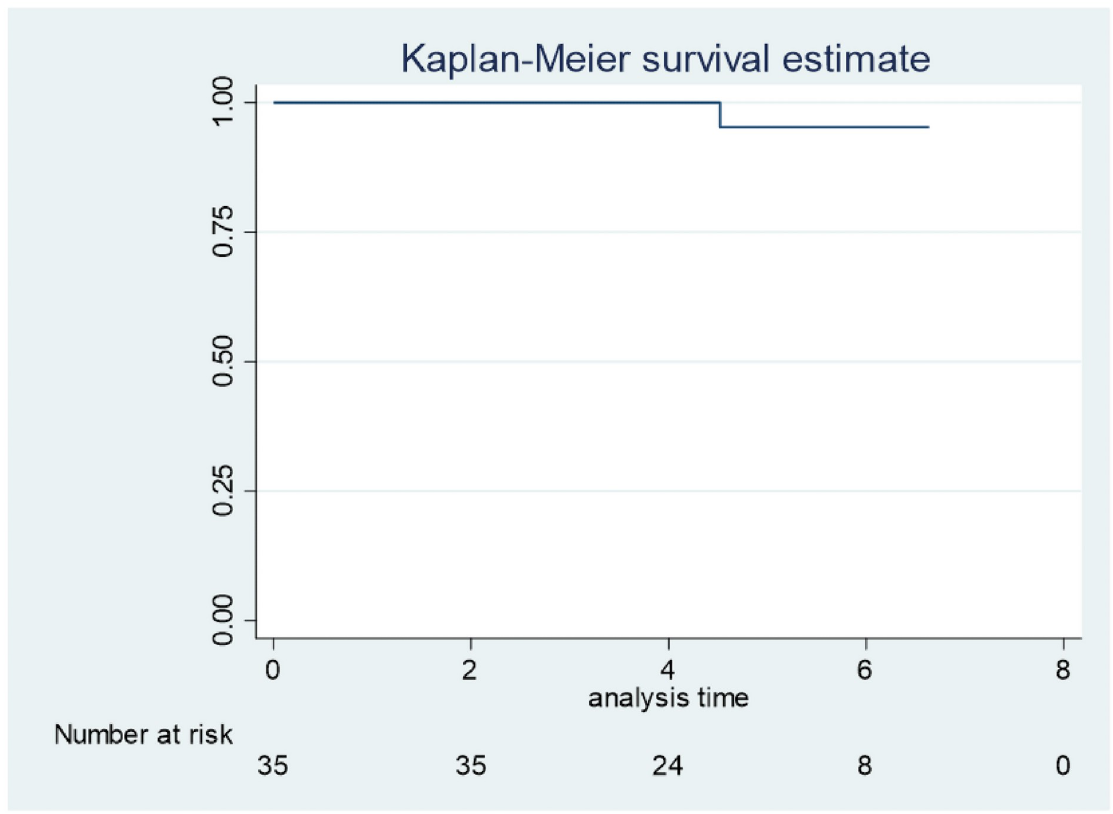
Fig 3. Kaplan-Meier analysis. Time to filtration surgery. All eyes at each time point. Success 95.2% Kaplan-Meier survival curve.